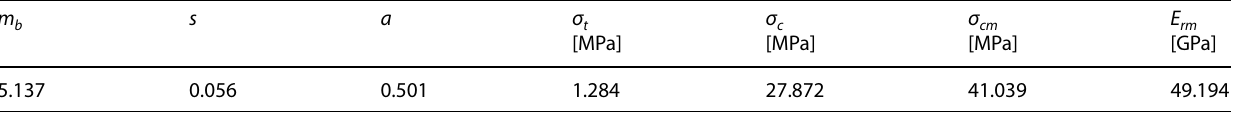
Table 12 Deterministic calculation of the Hoek–Brown and Mohr–Coulomb failure constants for the carbonatite-syenite rock mass m